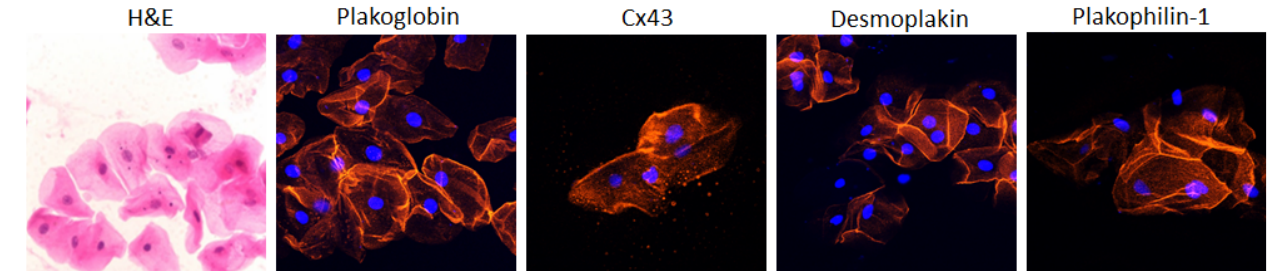
Figure 1. Representative confocal immunofluorescence images of buccal epithelial cells obtained from healthy controls. In the first image, cells are stained with hematoxylin and eosin (H&E). They show the typical squamous morphology; they have small central nuclei; and their edges are clearly identified. The remaining images show control buccal cells immunostained for plakoglobin, Cx43, desmoplakin and PKP1. The immunoreactive signal for all four proteins is strong and clearly localizes at the cell borders. Cell nuclei (blue) were stained with DAPI [59].